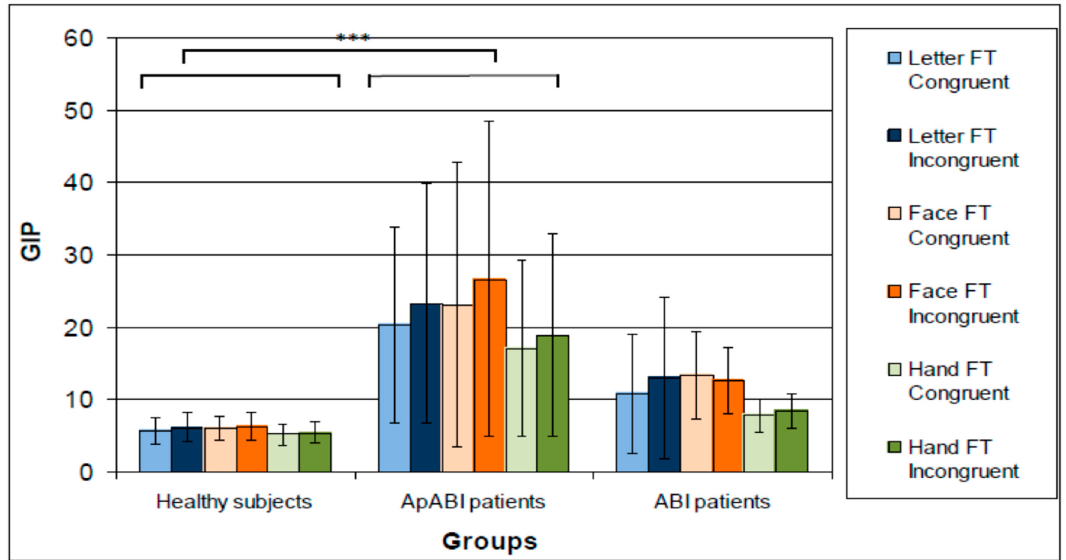
Figure 3. Mean of the GIP (higher values correspond to worse performance) in healthy subjects, ApABI and ABI patients for letter (blue), face (orange), and hand (green) FT, in congruent (light color) and incongruent (dark color) trials. *** stand for p ≤